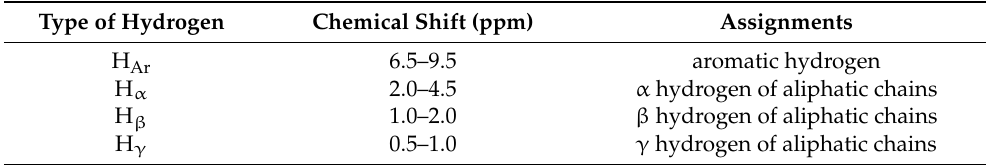
Table 5. Assignments of hydrogen atoms in 1 H NMR